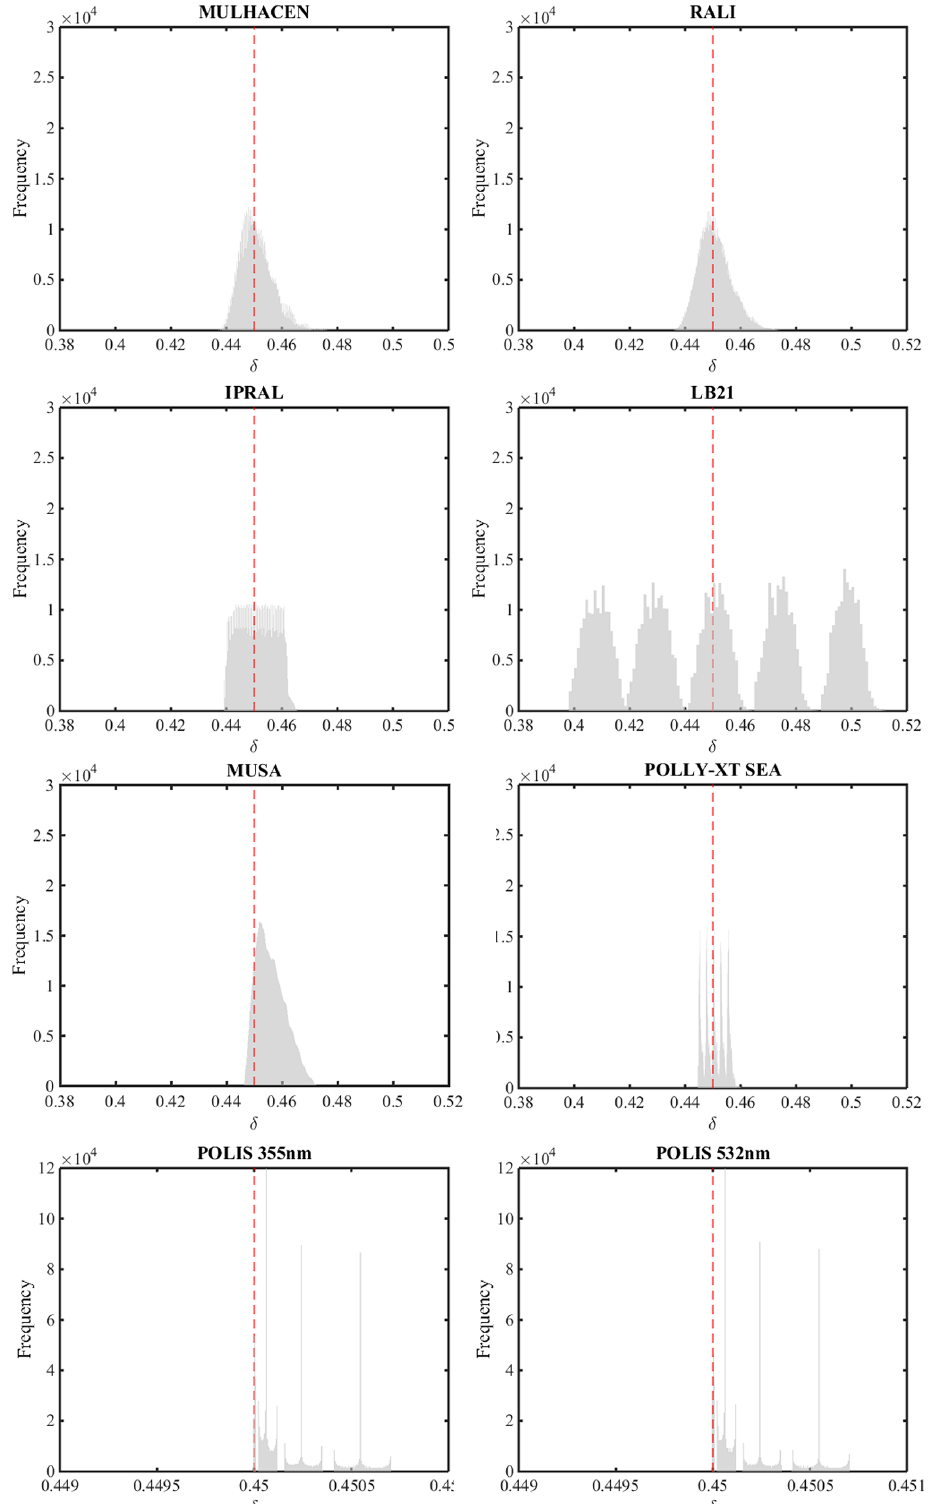
Figure 10. Histogram of the simulated δ values for several EARLINET lidars (Table 4). Dashed lines represent the δ r at 045. Please note the expanded x axis for